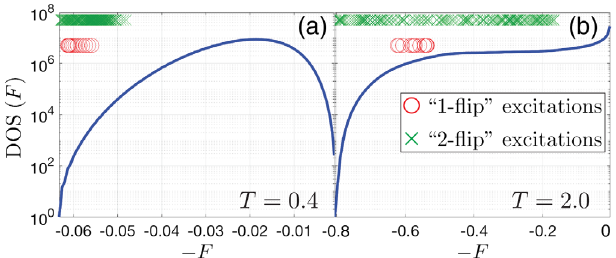
FIG. 6. Density of states (protocols) in the overconstrained phase at T ¼ 0 . 4 (a) and the glassy phase at T ¼ 2 . 0 (b) as a function of the fidelity F . The red circles and the green crosses show the fidelity of the “ one-spin ” flip and “ two-spin ” flip excitation protocols above the absolute ground state (i.e., the optimal protocol). The system size is L ¼ 6 and each protocol has 28 N T ¼